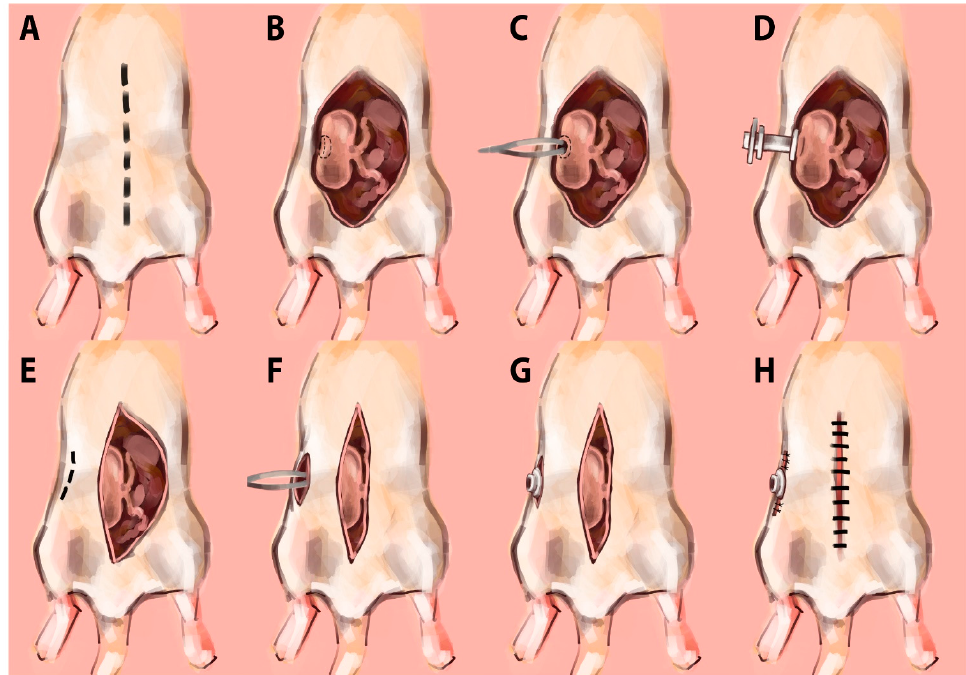
Figure 2. ( A – H ) Illustration of the surgical implantation method for the cecal fistula.